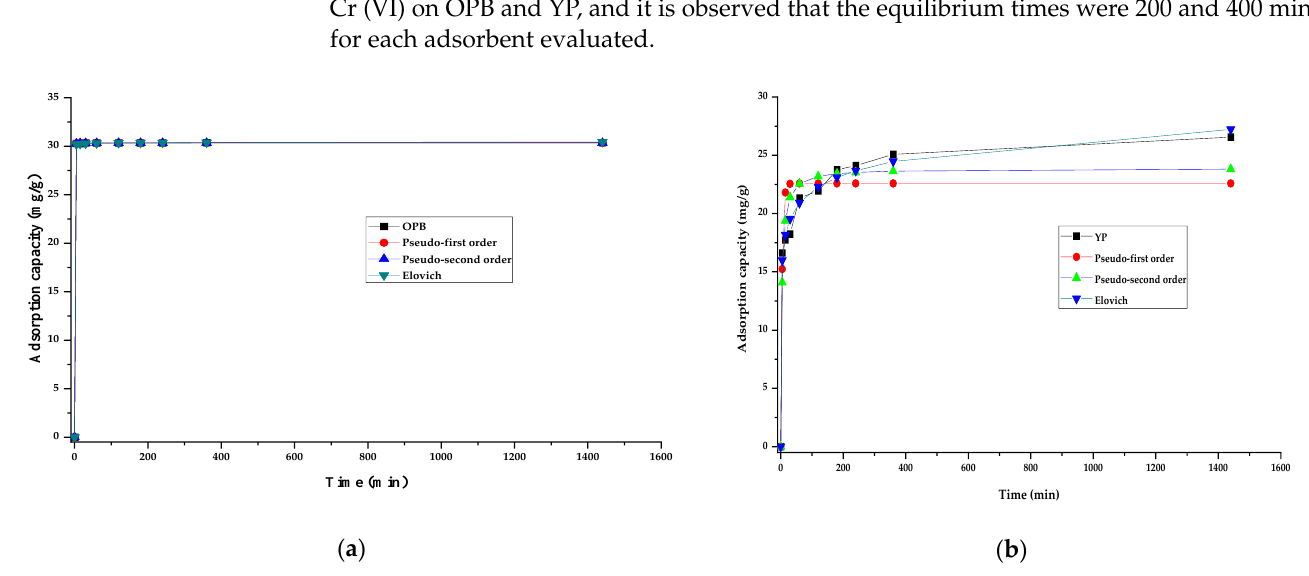
Figure 5. Non-linear fit to kinetic models of Cr (VI) adsorption on ( a ) OPB and ( b ) YP; at pH = 2, 200 rpm, 0.03 g of sweet adsorbent, 100 mg/L of initial concentration and 55 ◦ C. For both biomaterials, it is highlighted that about 70% of the equilibrium concentration was reached 120 min after the start of the test, showing that the available sites in the adsor- bent probably begin to saturate and therefore the capacity does not change significantly at higher times [45]. In order to study the adsorption mechanisms involved during the Cr (VI) removal process, pseudo-first-order, pseudo-second-order and Elovich linearized kinetic models were used, in their non-linearized forms. The parameters of these models were adjusted by linear regression and the results are shown in Table